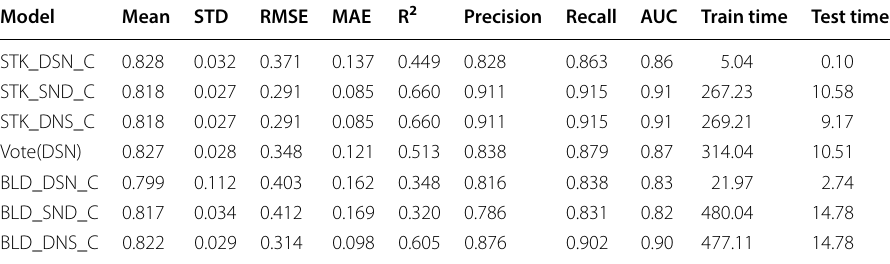
Table 21 Stacking and blending ensemble classifiers error metrics result on JSE dataset